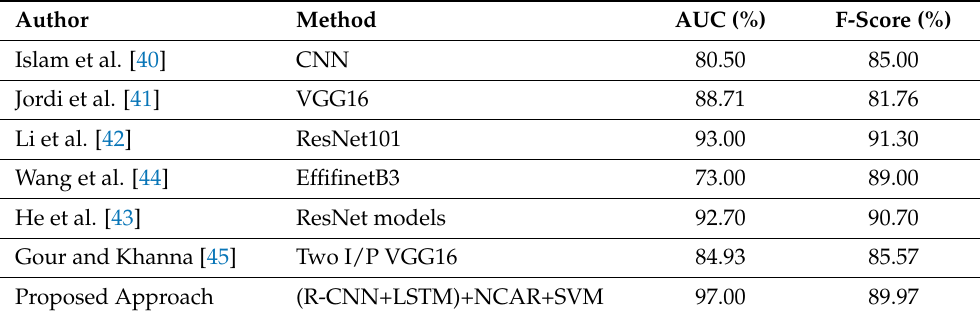
Table 4. The AUC and F-score results of the proposed approach and the existing approaches.